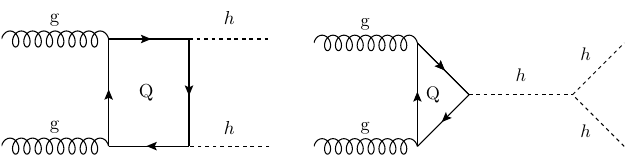
Figure 3 . The cross-section of the gg F channel can be decomposed into three subprocesses based on their dependence on the trilinear Higgs self-coupling, λ . The triangle topology depends on λ 2 , the box topology does not depend on λ and the interference amongst the latter two is linear in λ .